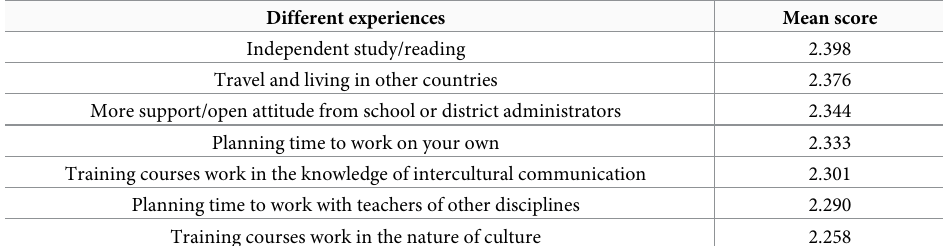
Table 8. The helpfulness of different experiences.